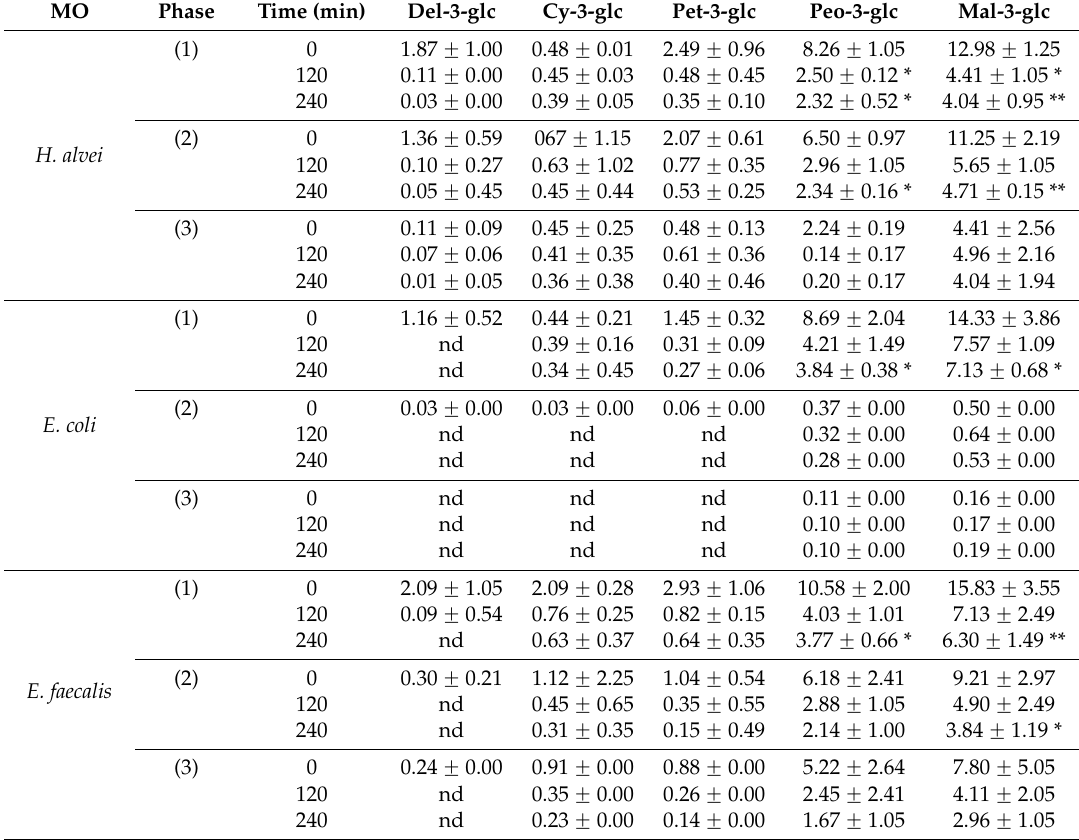
Table 3. Degradation rates of ACNs as a function of incubation time in Caco-2 cells 1 .